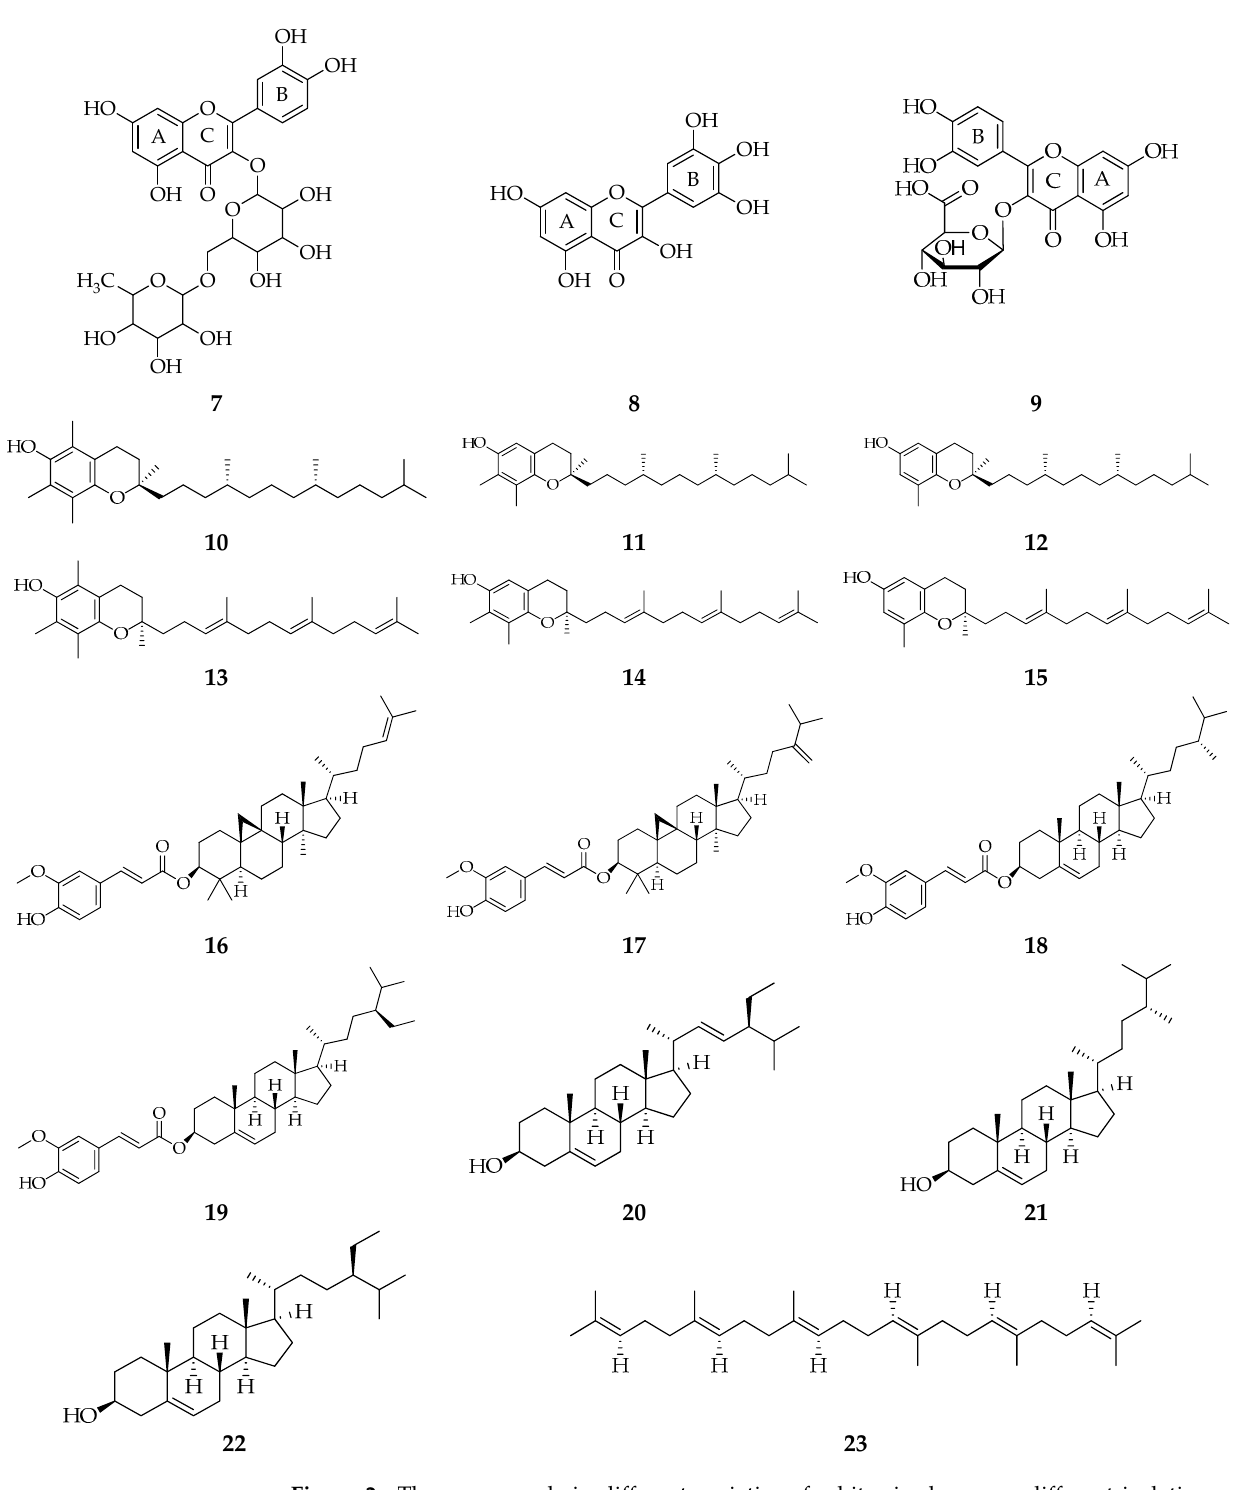
Figure 2 . The compounds in different varieties of white rice bran use different isolation methods.